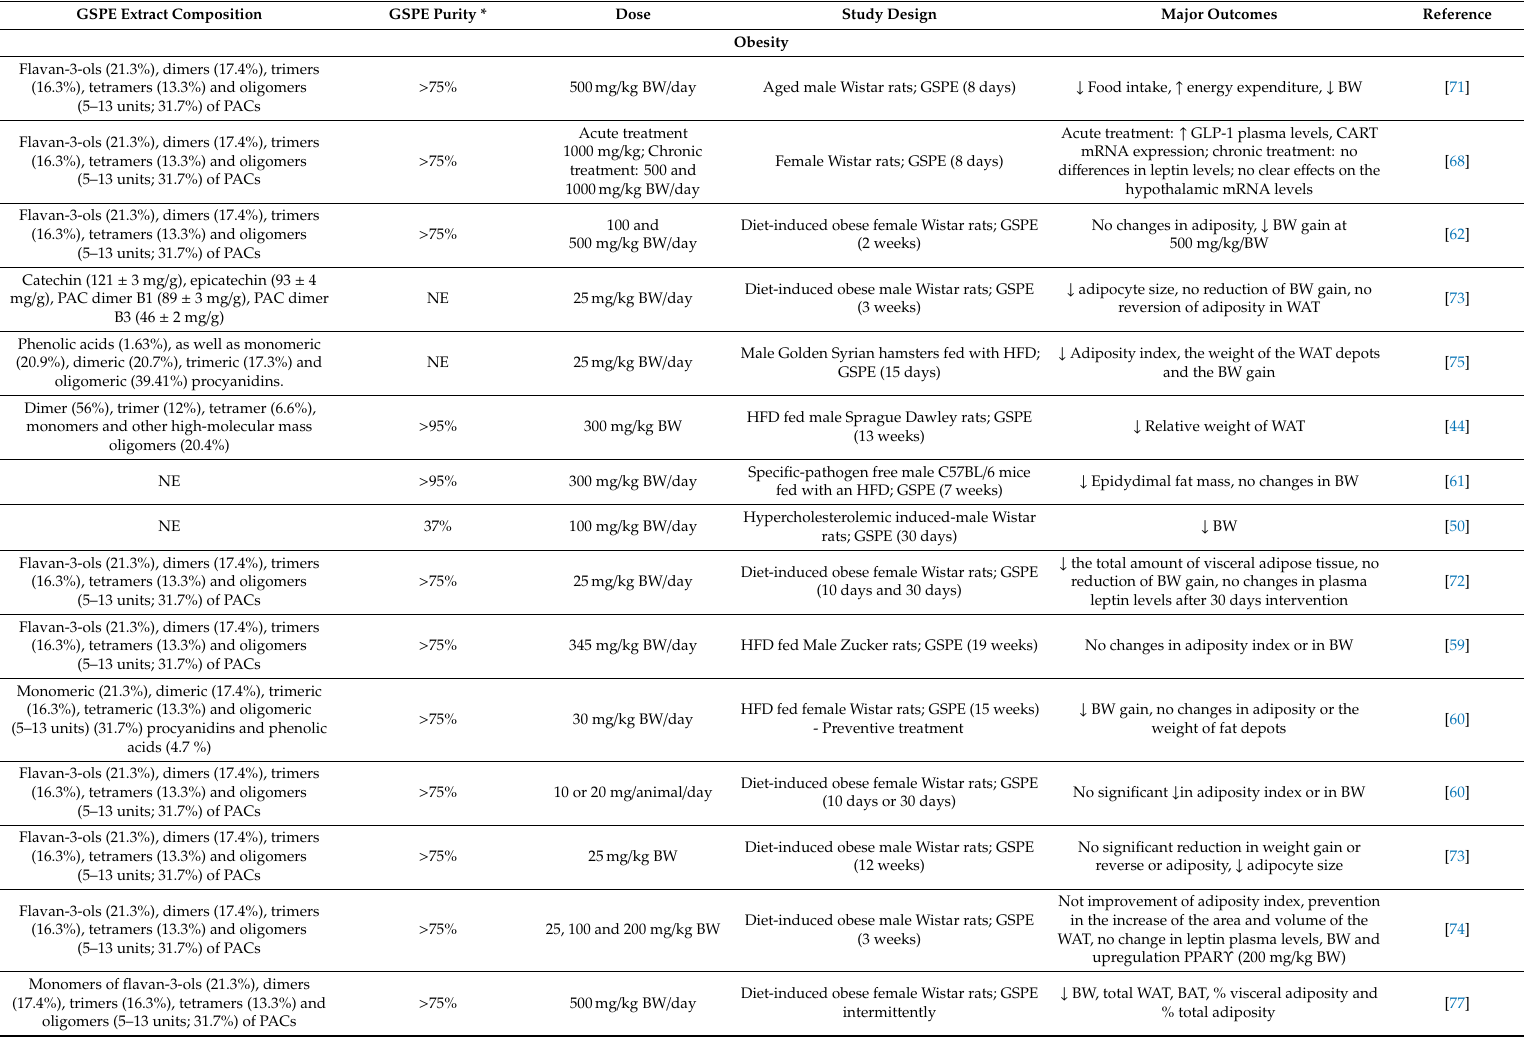
Table 3. E ff ect of proanthocyanidins from grape seeds on metabolic syndrome-related diseases in animal models. GSPE Extract Composition Major Outcomes